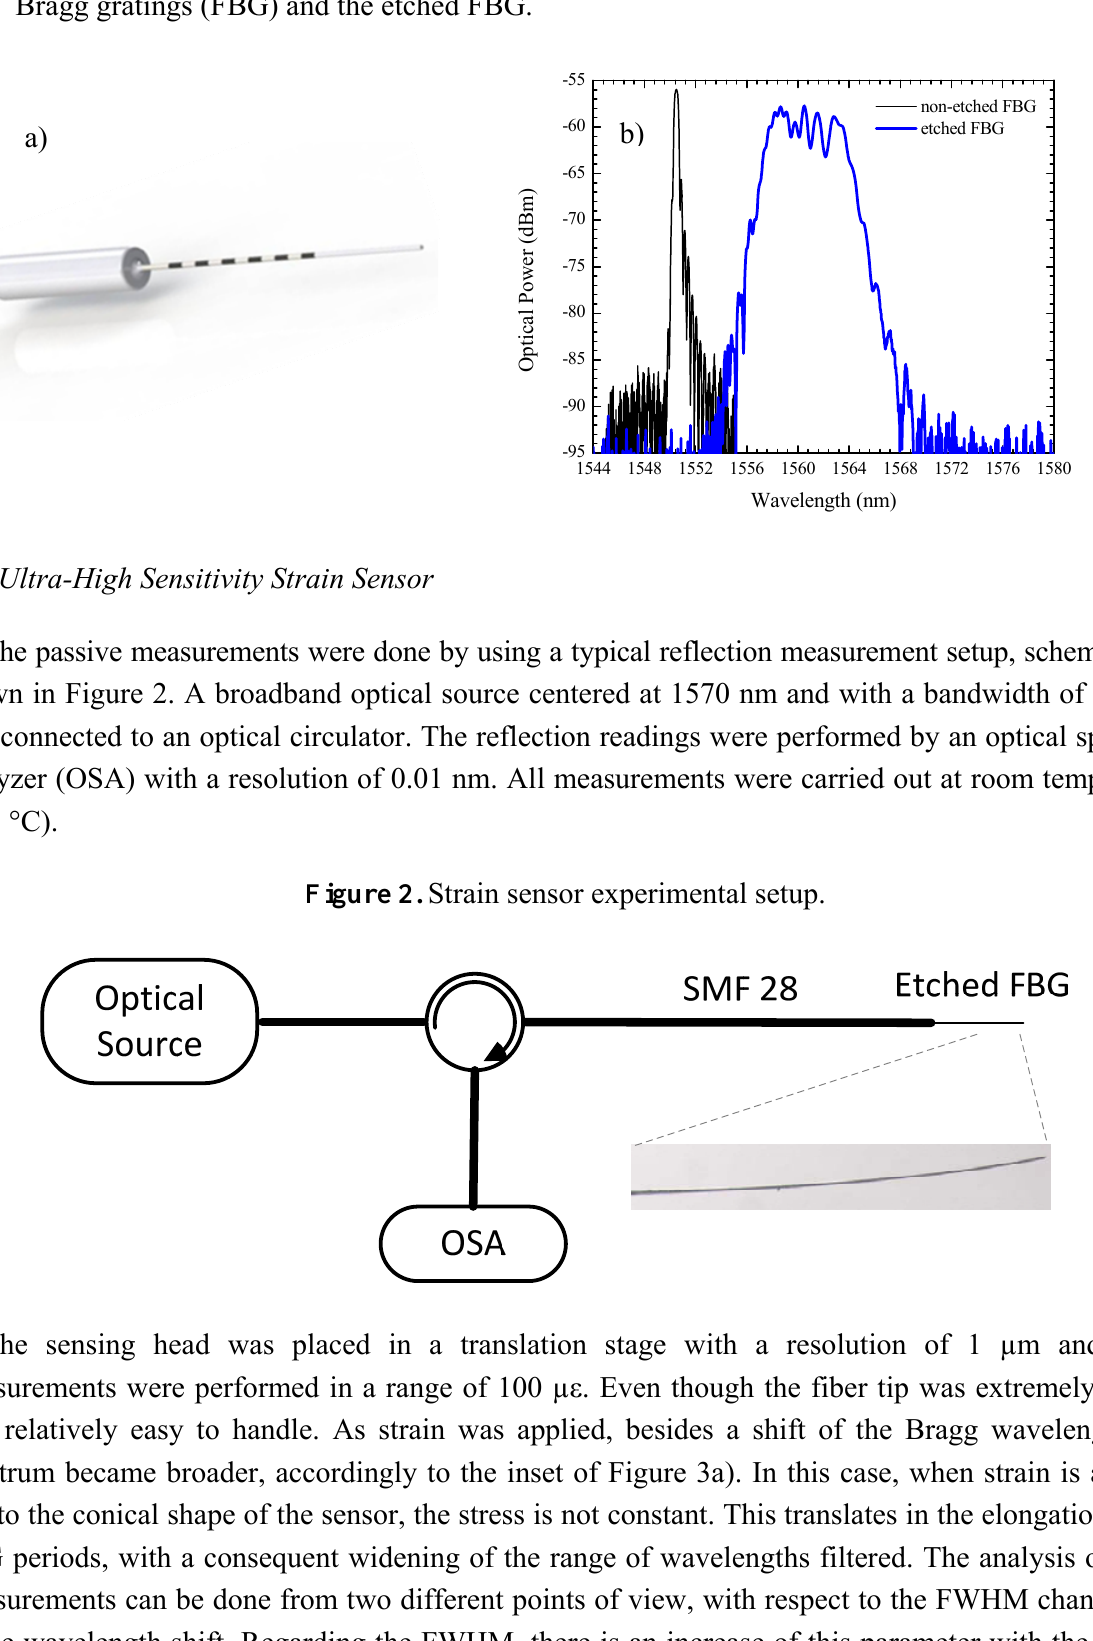
Figure 1. ( a ) Fiber tip schematic design; ( b ) Reflection spectra of the un-etched fiber Bragg gratings (FBG) and the etched FBG.